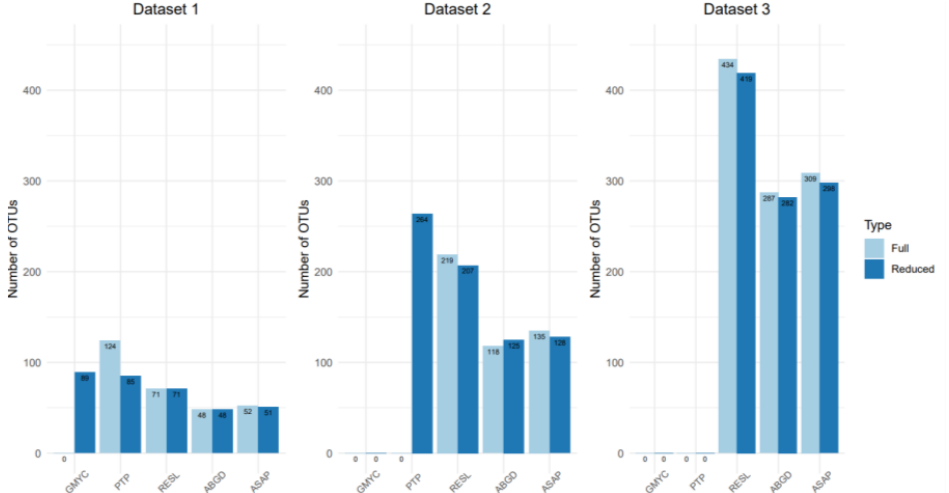
Figure 6. Number of OTUs obtained from three datasets (both in their full version or after reduced to a single sequence per haplotype) with five different delineation methods.